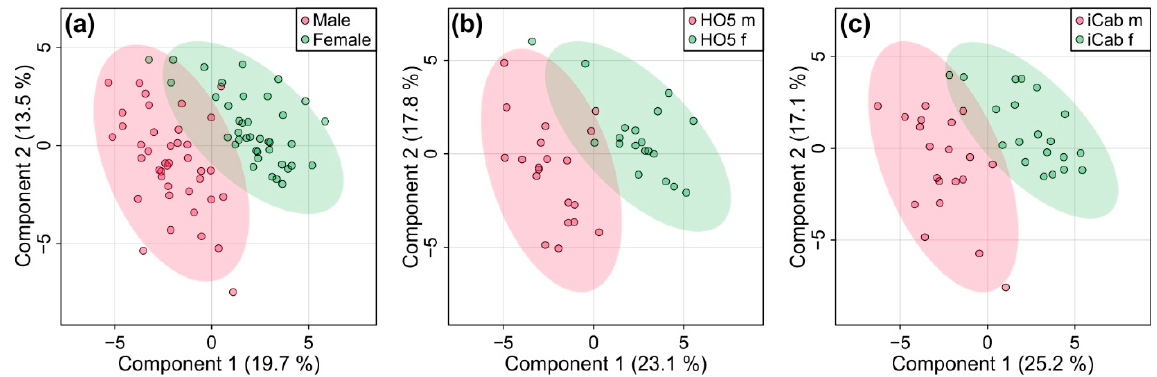
Figure 4. Partial least squares ‐ discriminant analysis for discriminating male and female fish ( a ) for HO5 and iCab together and separated into ( b ) HO5 and ( c ) iCab.